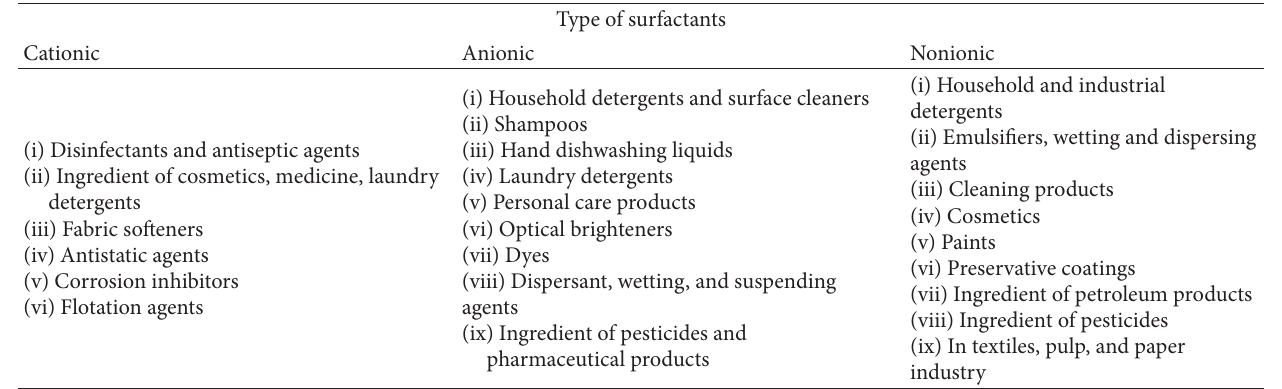
Table 1: The areas of surfactants application